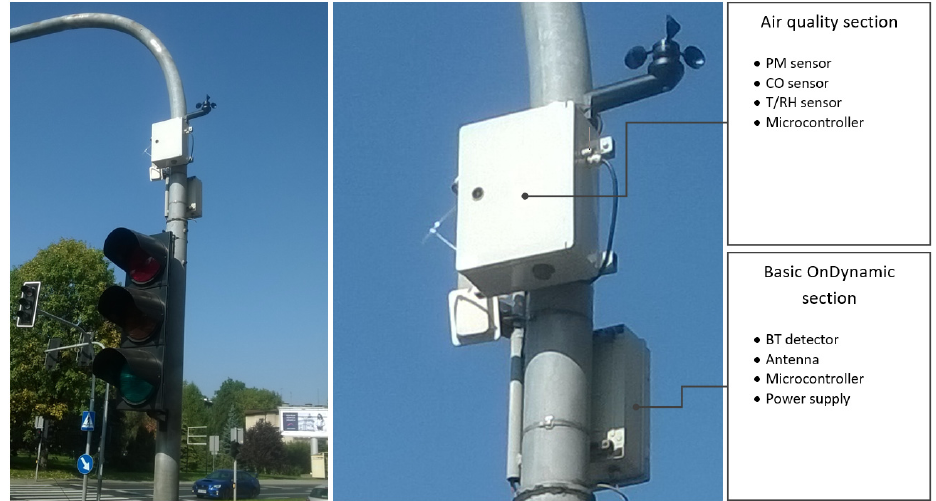
Figure 2. The view of the OnDynamic’s extended base station (T/RH—temperature and relative humidity; BT—Bluetooth).